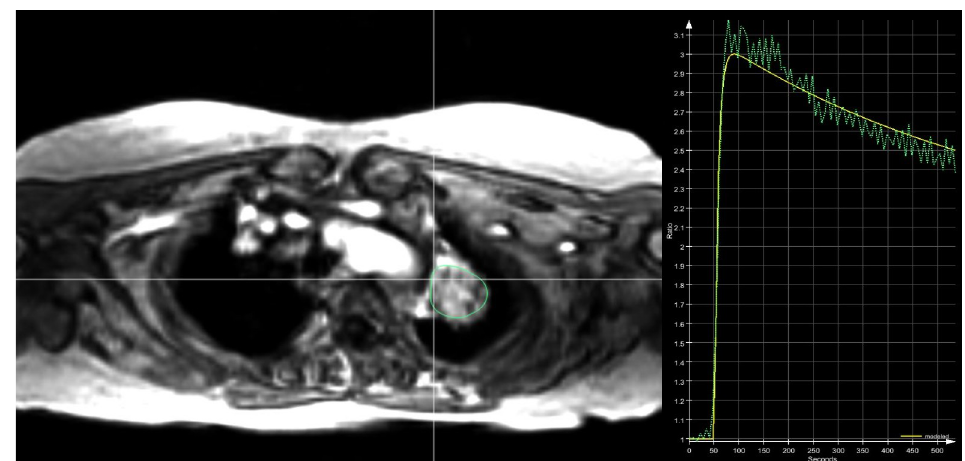
Fig 1. ROI placement and K trans analysis. Example of ROI placement in a lung tumor of the left upper lobe (left) and derived time curve of contrast agent enhancement (right) using the PulmoMR software (Mevis Fraunhofer, Bremen, Germany).